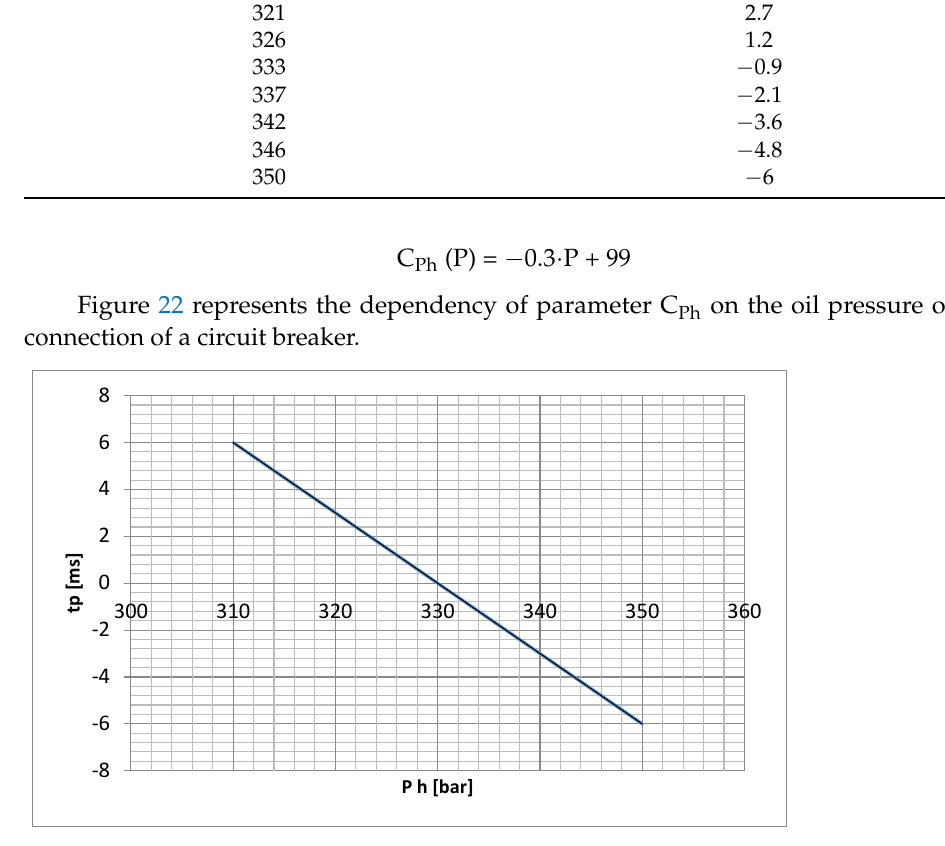
Figure 22. Time delay characteristic of the oil pressure on the connection of a circuit breaker.